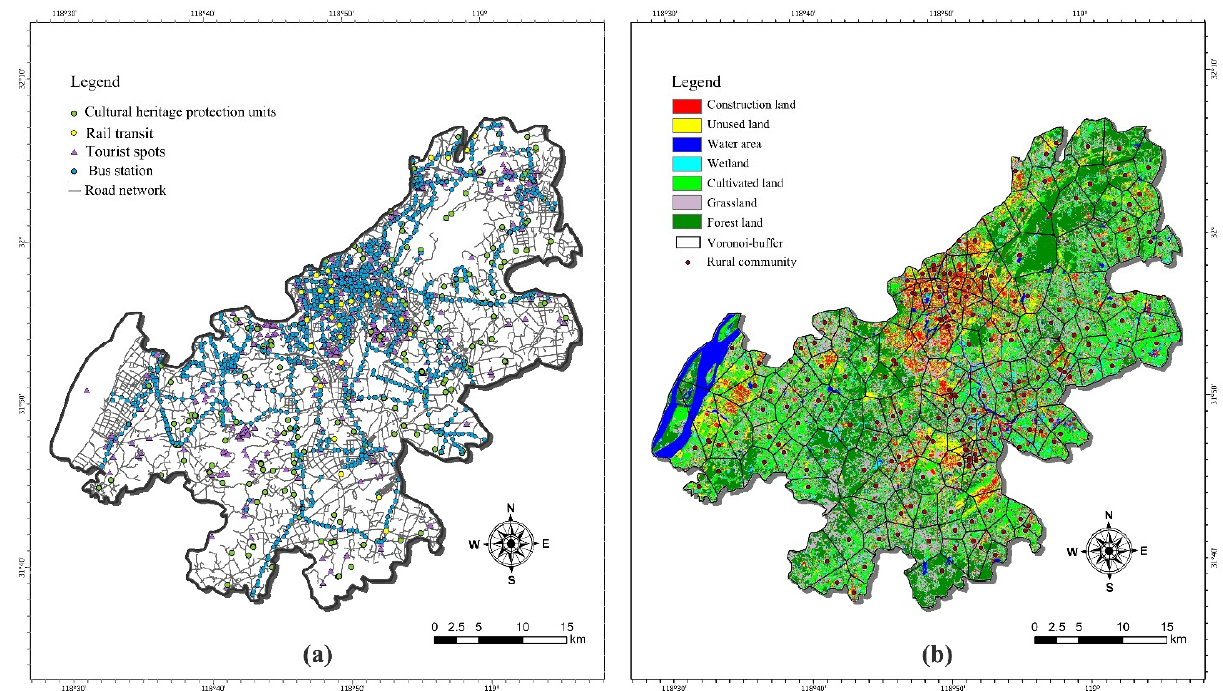
Figure 2. Basic data of the study area. ( a ) Landscape resources distribution plan. ( b ) Land use classification map and Thiessen polygon buffer of rural communities.